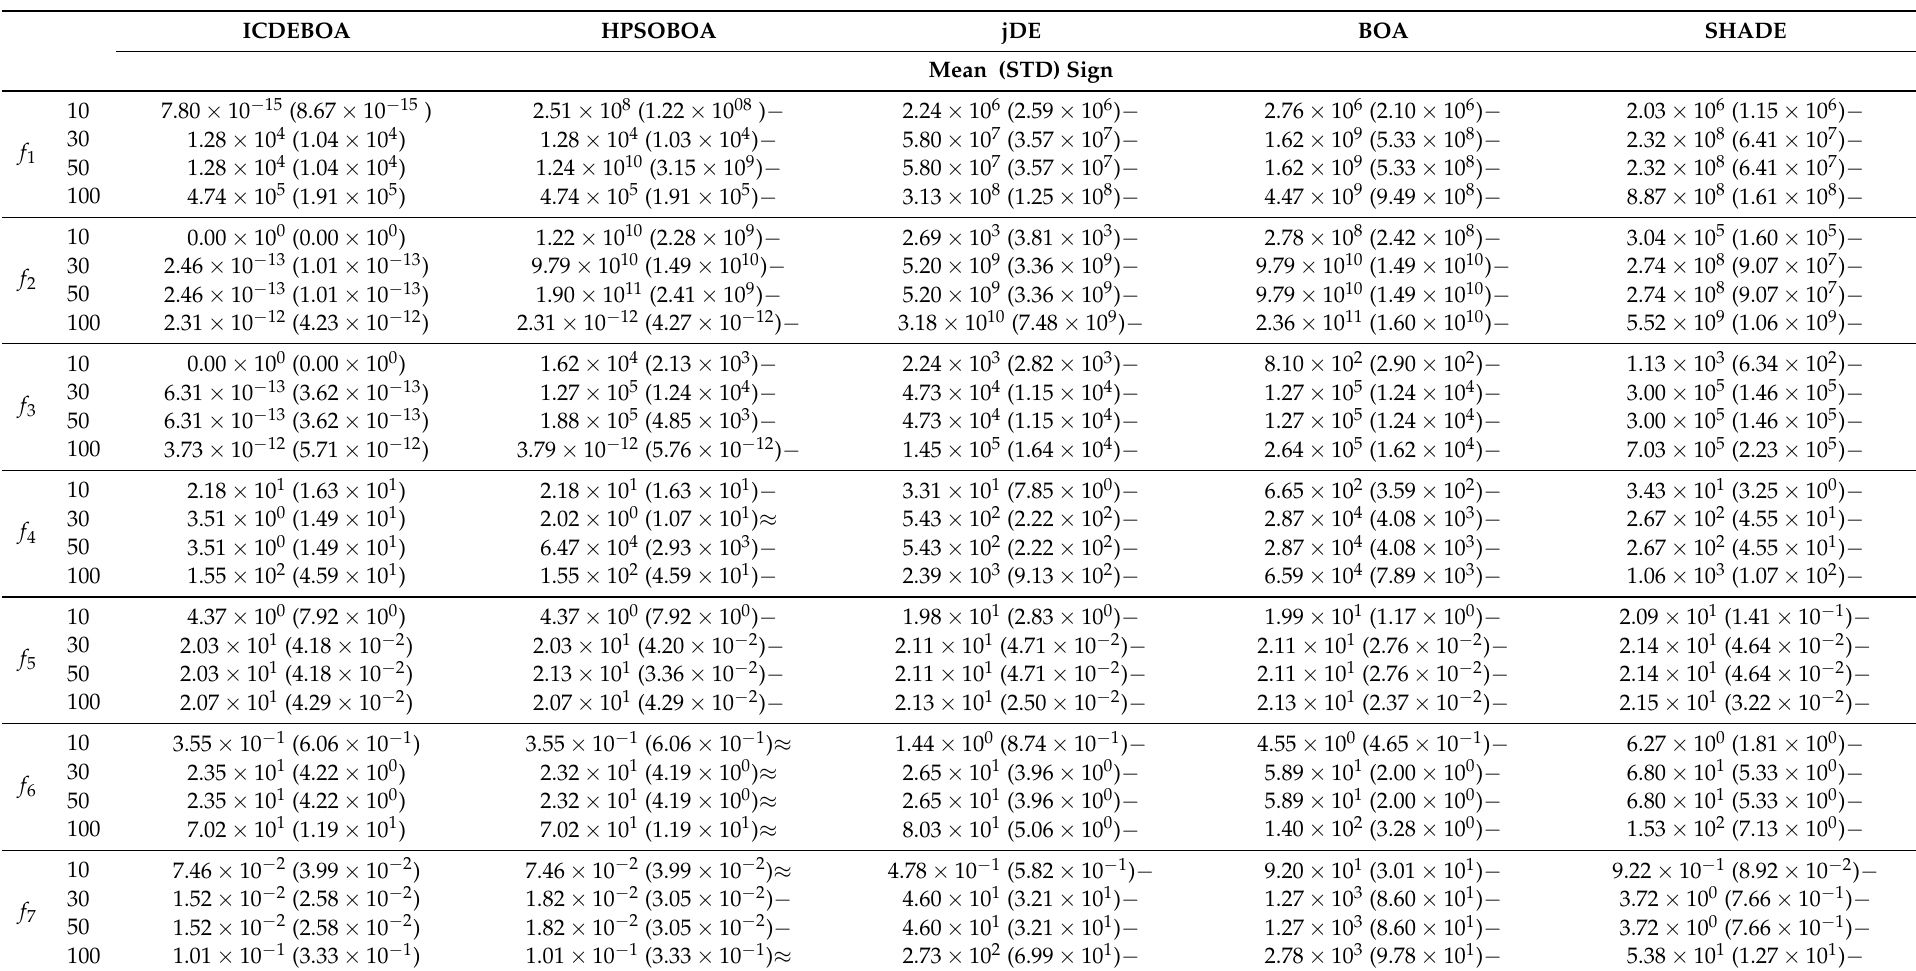
Table 2. Mean and standard deviation of the best objective function value obtained by the considered algorithms on a set of the CEC2014 test